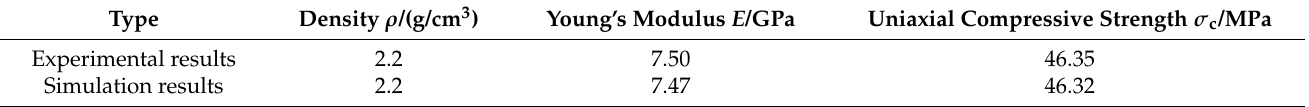
Table 2. Comparison of laboratory test results and numerical simulation